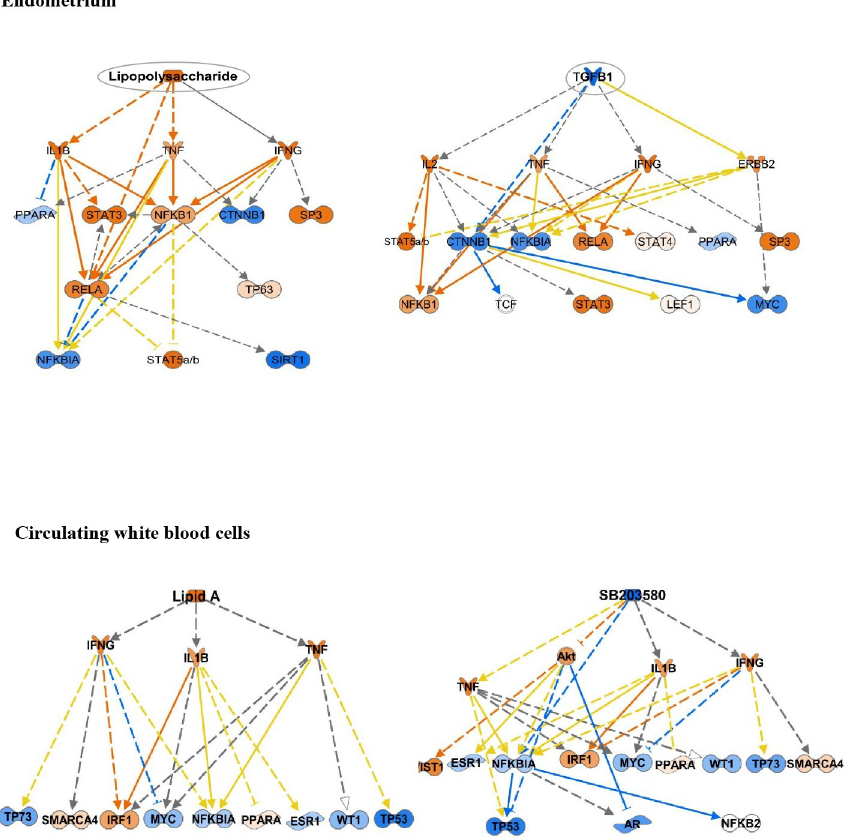
Fig 4. The mechanistic network of the upstream regulators and their relationship predicted by Ingenuity Pathway analysis (IPA). The molecules shown in orange are predicted to be activated (Z-Score � 2, p-value of overlap � 0.05) while the molecules shown in blue are predicted to be inhibited (Z-Score � -2, p-value of overlap � 0.05). Orange and blue dashed lines with arrows indicate indirect activation and inhibition, respectively. Yellow and grey dashed lines with arrows indicate inconsistent effects and no prediction, respectively. ( A ) Lipopolysaccharide (Z-score = +3.37, p- value of overlap = 0.0000894) and ( C ) Lipid A (Z-score = +2.24, p-value of overlap = 0.000268) are predicted to be activated in the endometrium and in the circulating white blood cells of cows with subclinical endometritis (SCE) compared with healthy dairy Holstein cows at 45–55 days postpartum (DPP), respectively. ( B) TGFB1 (Z-score = -2.55, p-value of overlap = 0.00152) and ( D ) a chemical—kinase inhibitor such SB203580 (Z-score = -2.22, p-value of overlap = 0.00103) are predicted to be inhibited in the endometrium and in the circulating white blood cells of SCE cows compared with healthy cows at 45–55 DPP, respectively. Orange and blue solid lines with arrows indicate direct activation and inhibition, respectively.